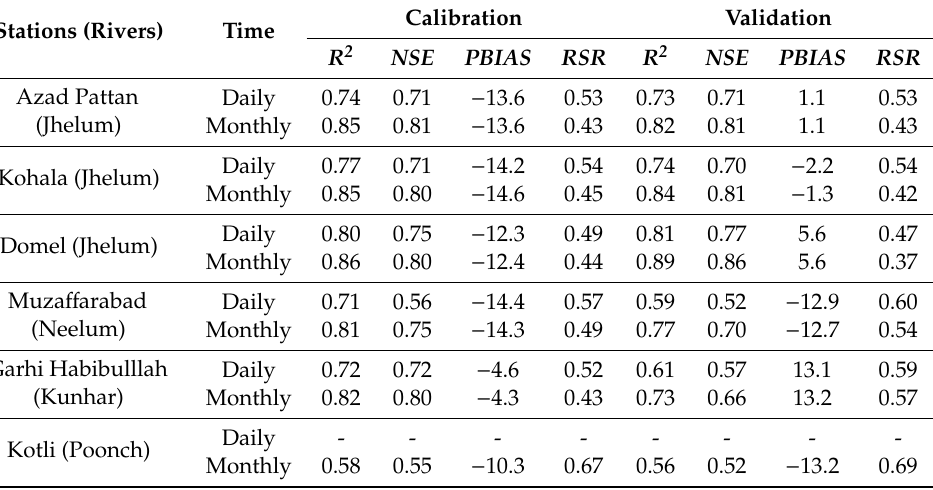
Figure 4. Comparison of the observed and simulated stream (m 3 /s) flow at different stations ( a ) Azad Pattan ( b ) Kohala ( c ) Garhi Habibullah ( d ) Domel ( e ) M. Abad for the calibration and validation in the Jhelum River Basin. Table 5. Performance statistics for daily and monthly calibration and